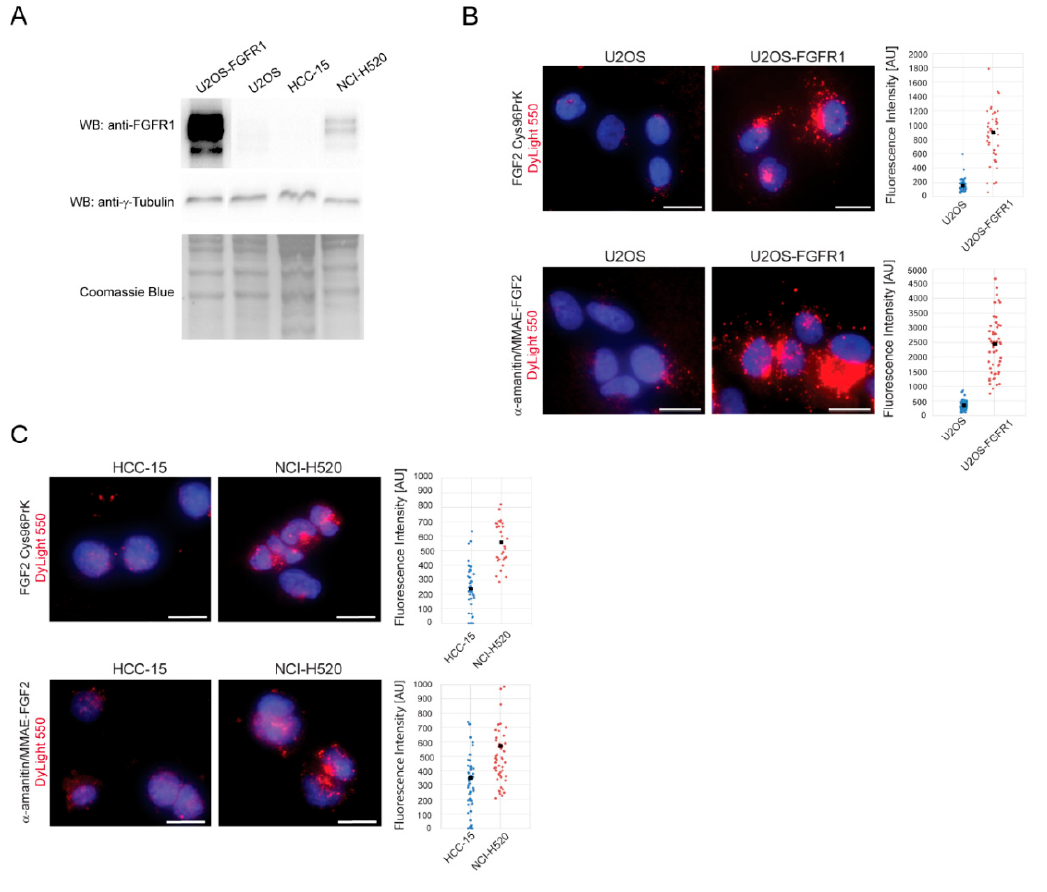
Figure 5. Quantitative analysis of FGF2 dual conjugate internalization into FGFR1-positive and FGFR1-negative cancer cell lines. ( A ) Western blot analysis of FGFR1 expression levels in tested cell lines. Coomassie staining was used as a loading control; ( B ) Osteosarcoma cells (U2OS) (FGFR1-negative) and U2OS-FGFR1 (FGFR1-positive) cells were treated with FGF2 dual warhead conjugate labeled with DyLight550 and intensity of fluorescence within single cells was measured and plotted. Black spots represent average fluorescence intensity ( C ) An analogous experiment was performed on squamous cell lung carcinoma HCC-15 (FGFR1-negative) and NCI H520 (FGFR1-positive). For both models, FGFR1-expressing cell lines (U2OS-FGFR1 and NCI H520) showed efficient internalization. Scale bars represent 20 µm.